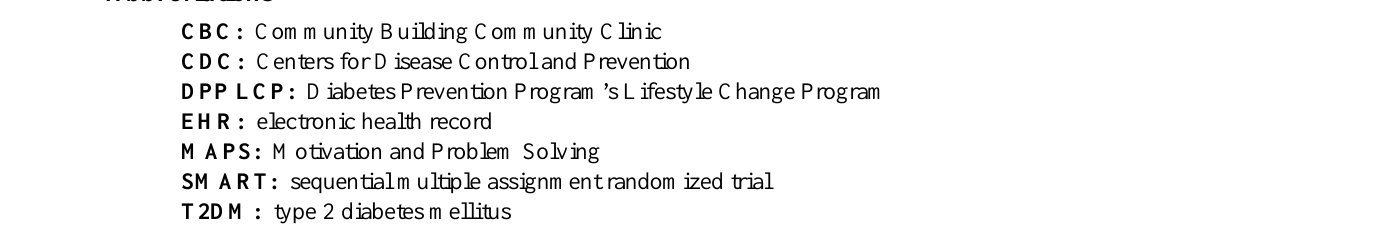
MAPS: Motivation and Problem